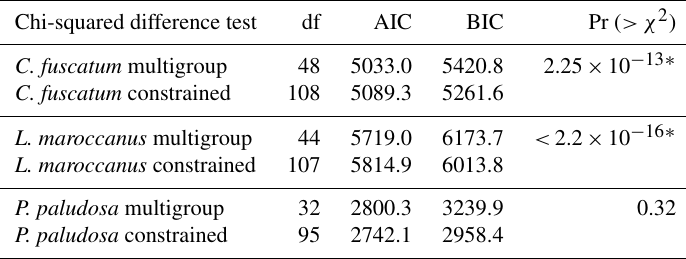
Table A3. ANOVA results for each plant species for both the constrained and the multigroup model. This allows for checking if the models should include the spatial scale (multigroup models) or not (constrained models). For each species, we selected the model with the lowest AIC and tested if models differ using an ANOVA. The “ ∗ ” symbol means that the ANOVA is significant, which implies that both models are different. In the case of C. fuscatum and L. maroccanus , the models that are more parsimonious (lower AIC) are the multigroup model, and in the case of P. paludosa , the most parsimonious model is the constrained model. BIC denotes the Bayesian information criterion.